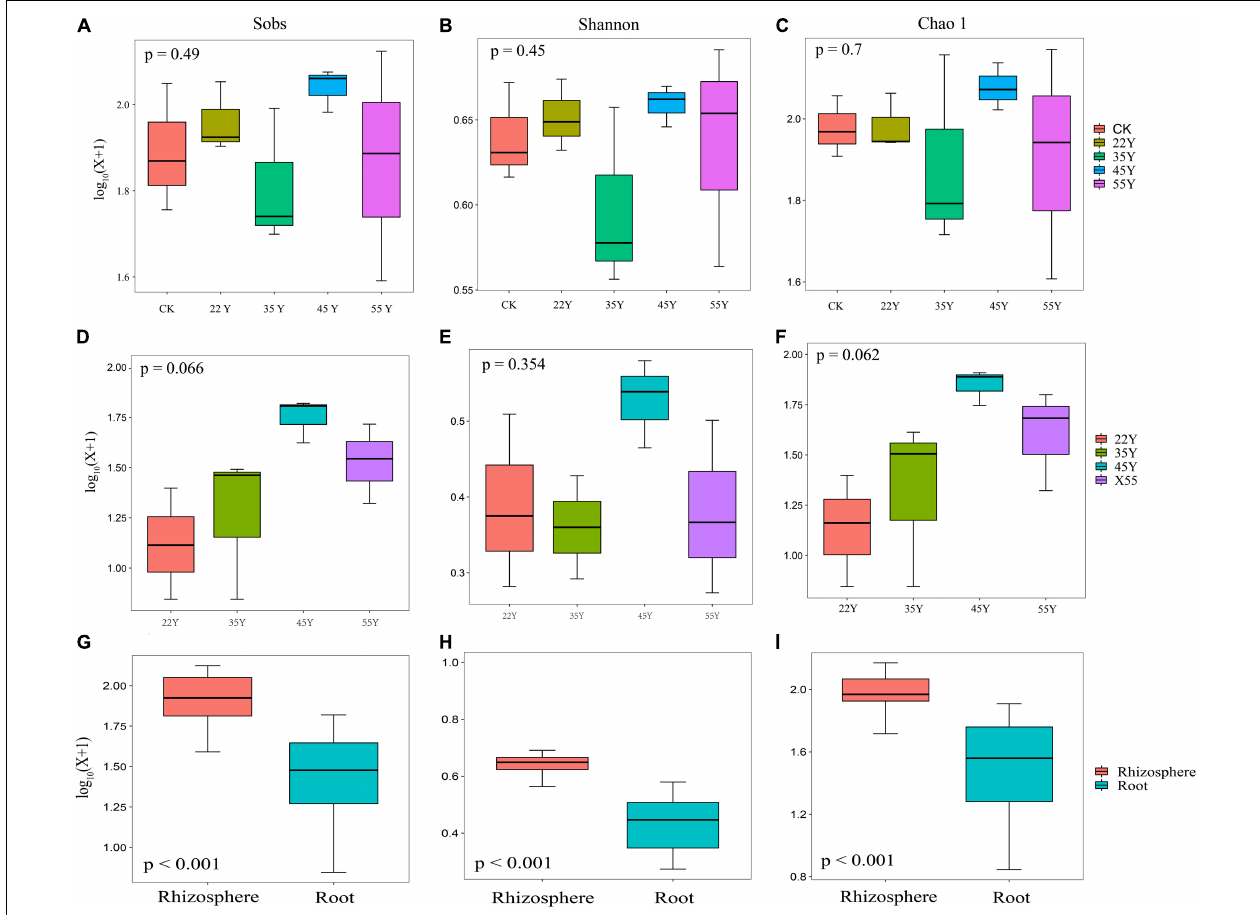
FIGURE 2 | AM fungal community diversity in rhizosphere soils (A–C) and roots (D–F) along stand age ( n = 3). Alpha diversity indices (G–I) of AM fungal communities were compared between rhizosphere ( n = 15) and root ( n = 12) samples. All the diversity indices (at 97% sequence similarity) are delineated at the OUT